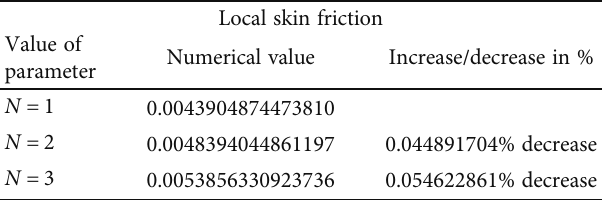
Table 10: Variability of the curve when Y = 1 in Figure 9(f).